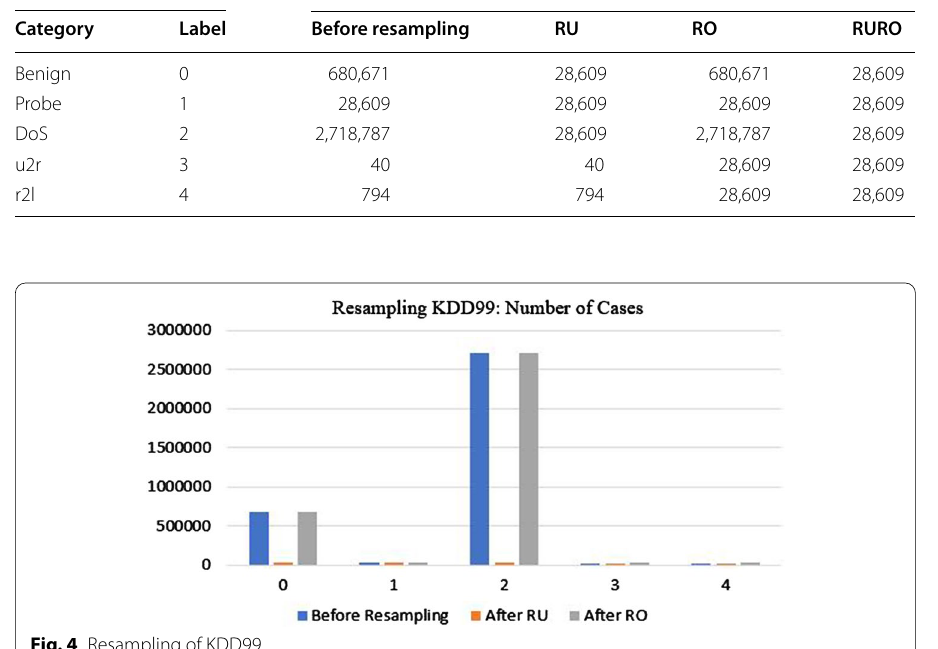
Table 10 Resampling of KDD99 KDD99 Number of cases for training model